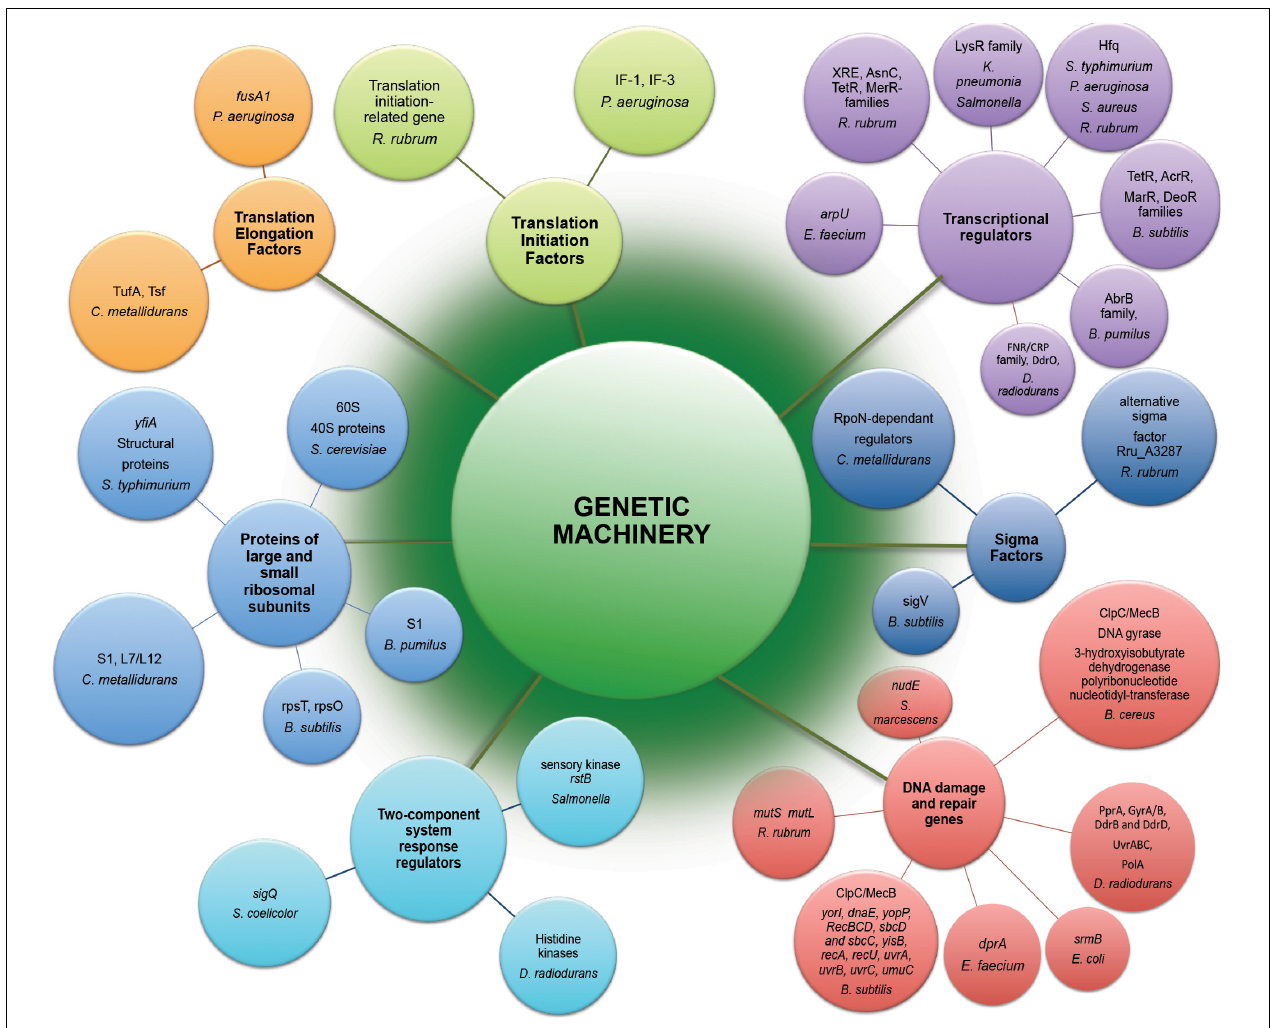
FIGURE 2 | Genetic machinery implicated in molecular response to exposure of microorganisms to the outer space environment. Represented are differently expressed genes and differently abundant proteins of microorganisms exposed to real and simulated space conditions ( Table 1 ) revealed by means of –omics assisted methodological